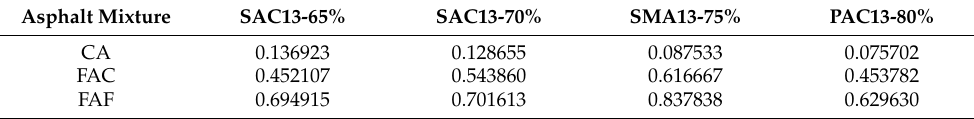
Table 4. Bailey method-based CA, FAC, and FAF ratios calculated for the four types of mixtures.